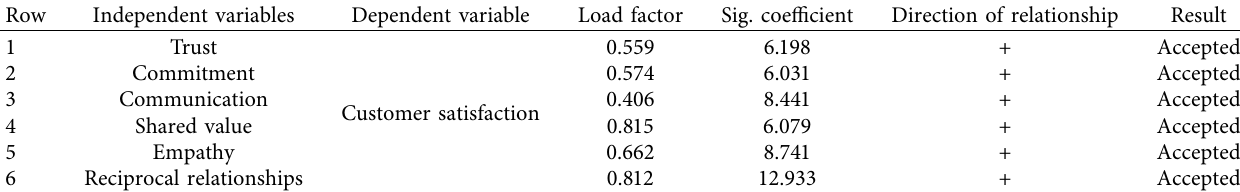
Table 10: Values of factor load (Figure 2) and significance coefficient (Figure 3) of the conceptual